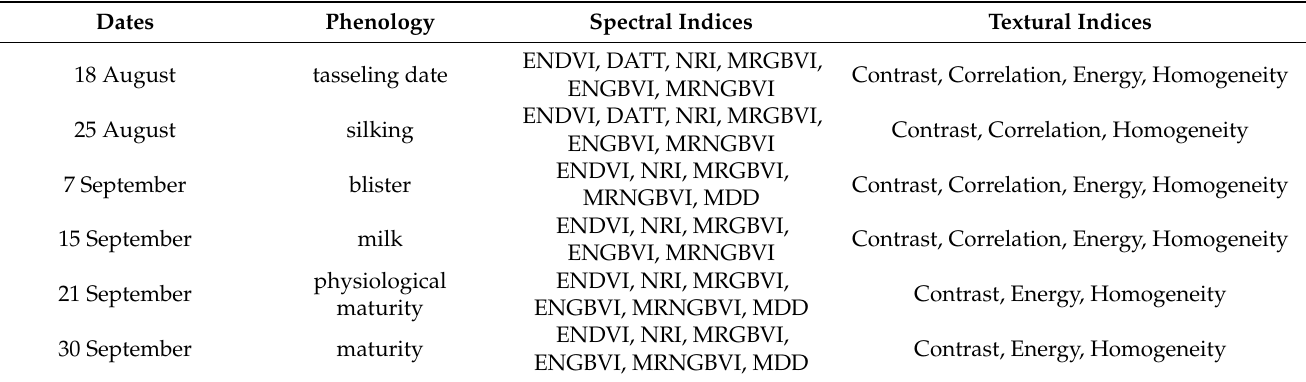
Table 5. The optimal combinations of spectral and textural indices for predicting SPAD values using stepwise regression model. The first column represents the different dates of data acquisition, the second column is the corresponding phenology, and the third and fourth columns are the optimized combinations of spectral and textural indices.